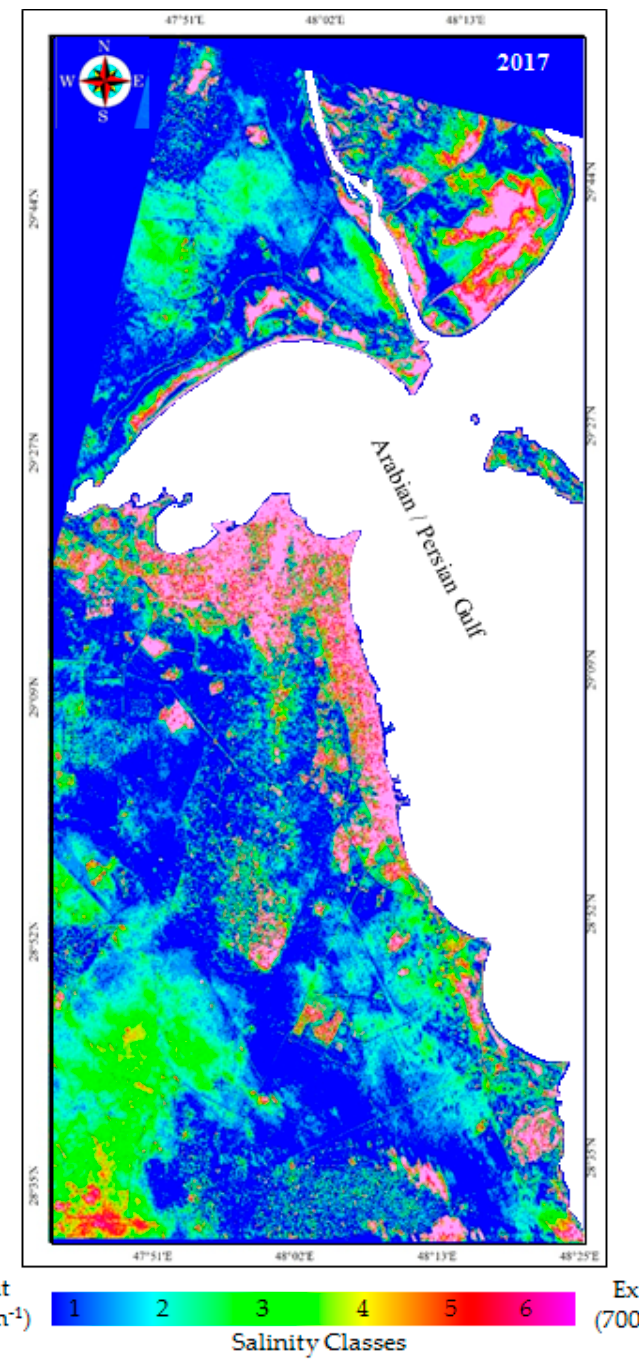
Figure 6. Derived soil salinity map for the year 2017 using the SEPM (unit in dS.m − 1 ).